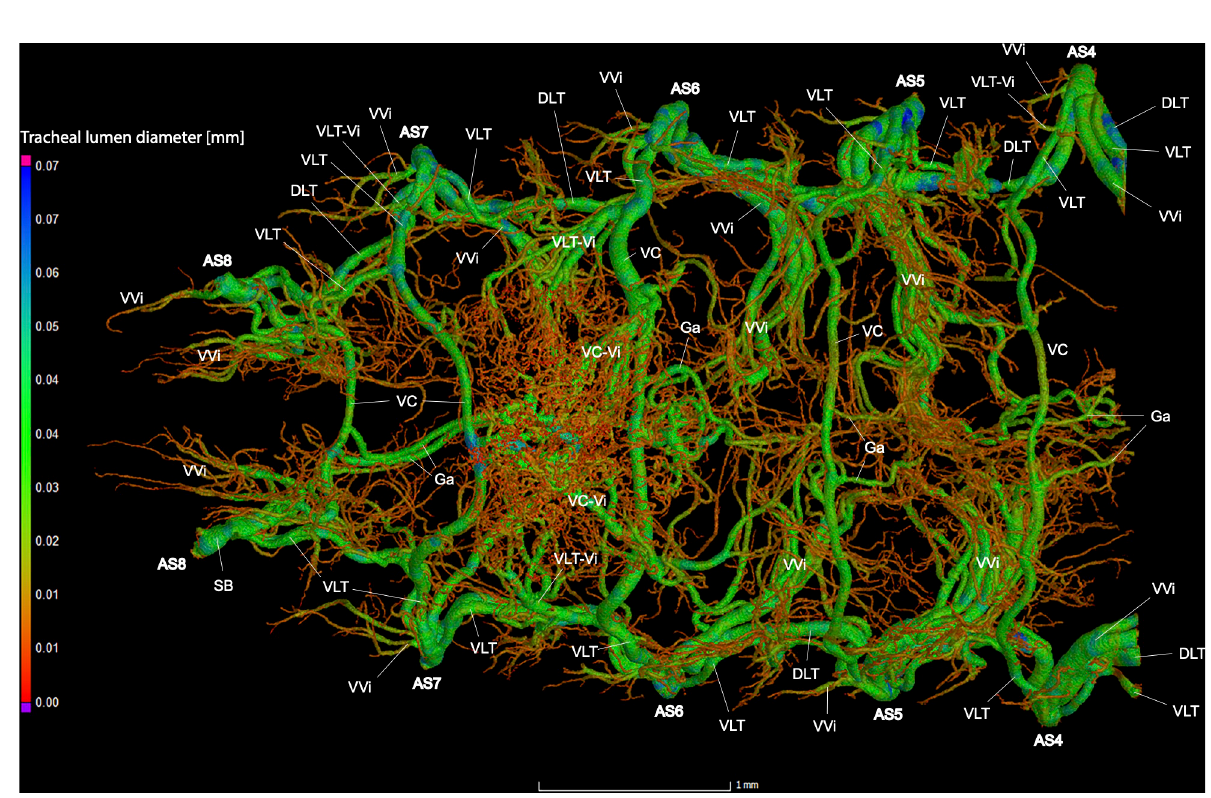
Fig 19. Ventral view of the abdominal tracheal system in adult female Photinus pyralis .